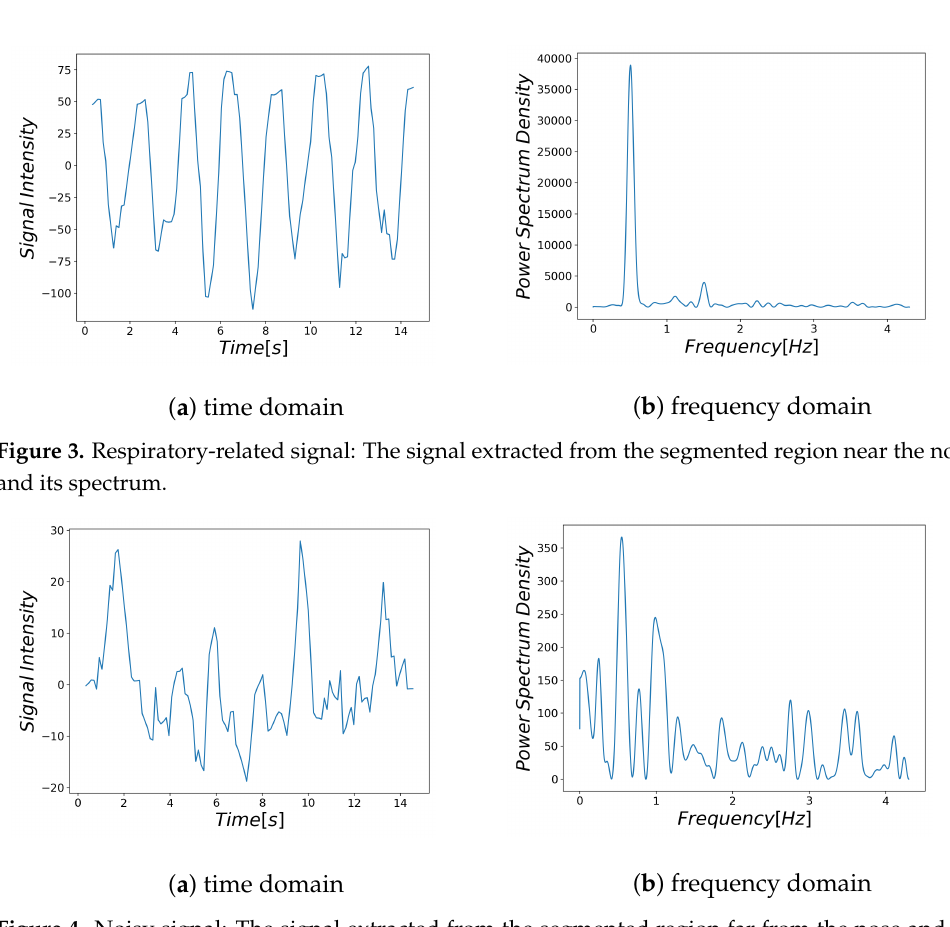
Figure 4. Noisy signal: The signal extracted from the segmented region far from the nose and its